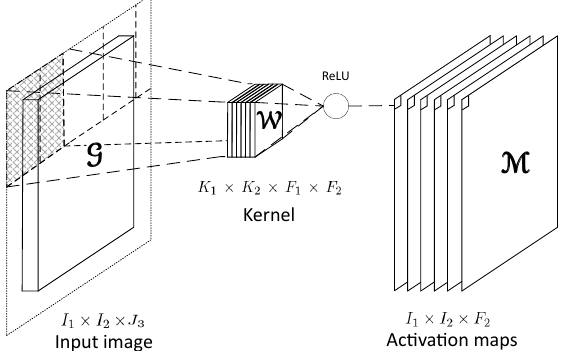
Figure 2. Convolutional layer with a K 1 × K 2 × F 1 × F 2 kernel. Input channels F 1 must equal the spectral bands I 3 . To preserve original dimensions at the output, zero padding is needed [18]. Output dimensions also depend on stride S = 1 to consider every piece of pixel information and to preserve original